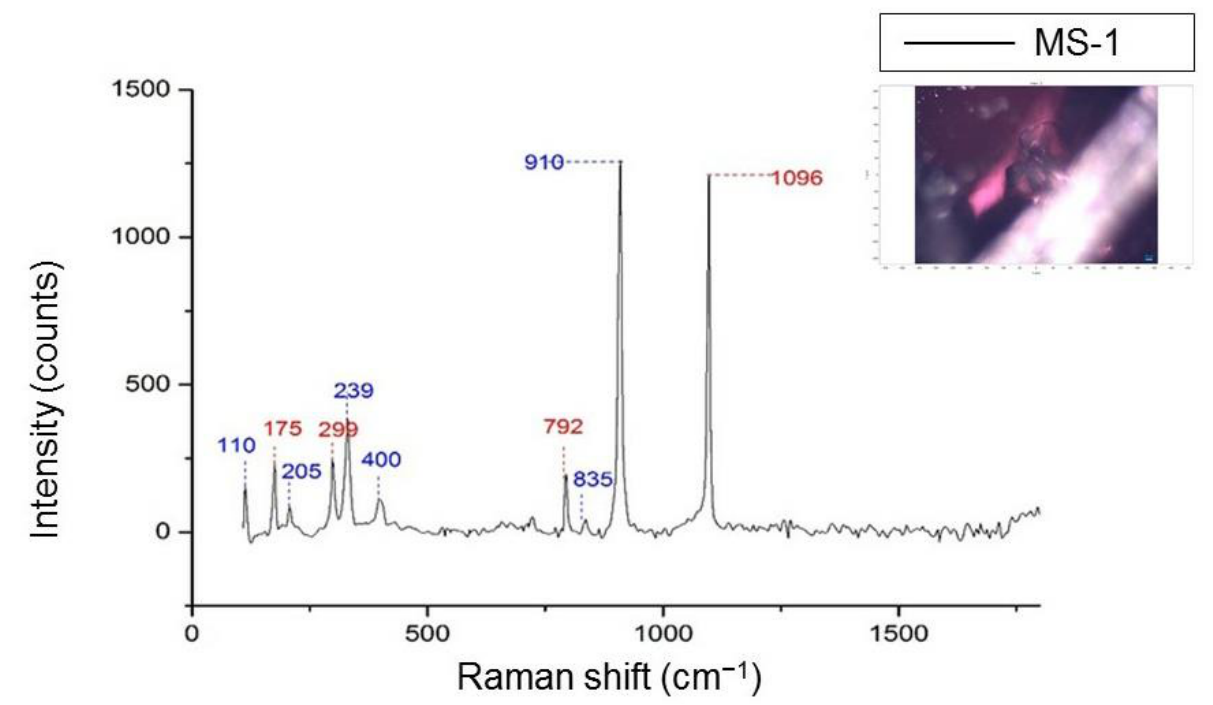
Figure 4. Raman spectroscopy octahedral morphology of negative crystalline solid inclusion (MS-1). Blue markings indicate the characteristic peaks of scheelite; red markings indicate the characteristic peaks of dolomite. Table 1. EDXRF data of ‘Jedi’ spinel from Man Sin (weight%).